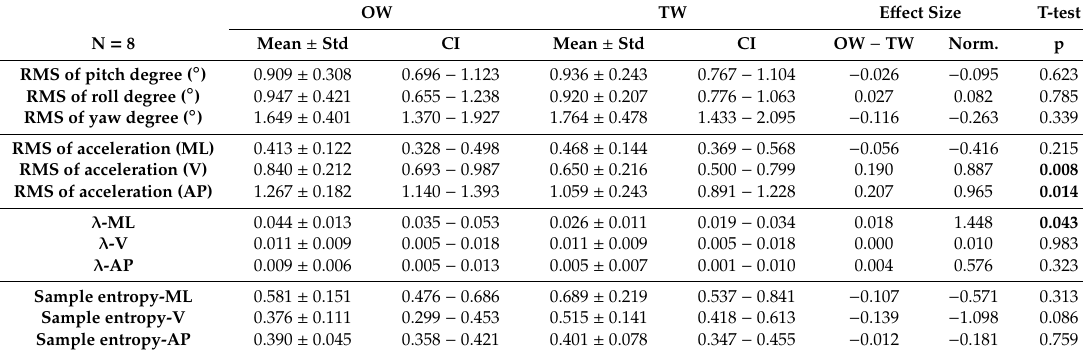
Table 7. Comparison of upper trunk features between TW and OW